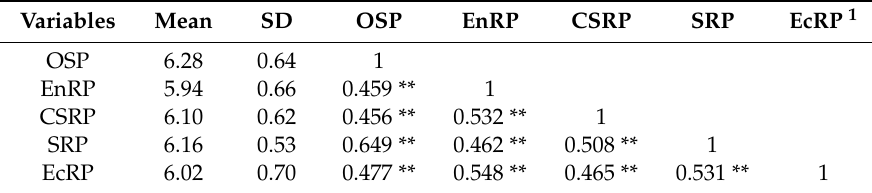
Table 3. Means, standard deviations, and Pearson